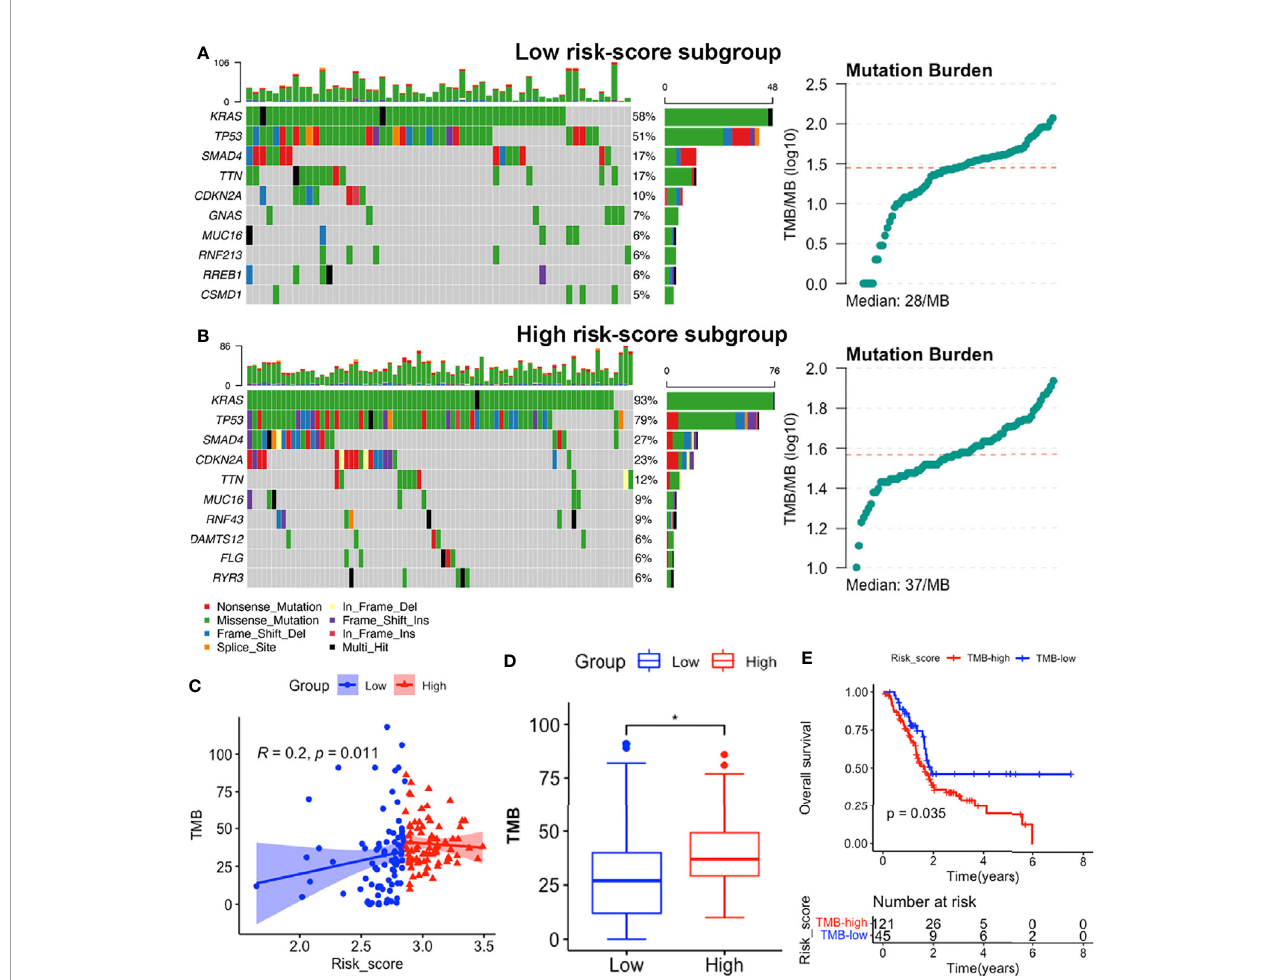
FIGURE 9 | Somatic mutation features between subgroups in the TCGA-PAAD dataset. (A, B) Somatic mutation landscape and TMB status of low-risk (A) and high-risk (B) subgroups. (C) Correlation between TMB levels with risk-scores. (D) Comparisons of TMB distributions of the two subgroups by t-test. (E) K-M survival curves showing OS of patients with high and low TMB.